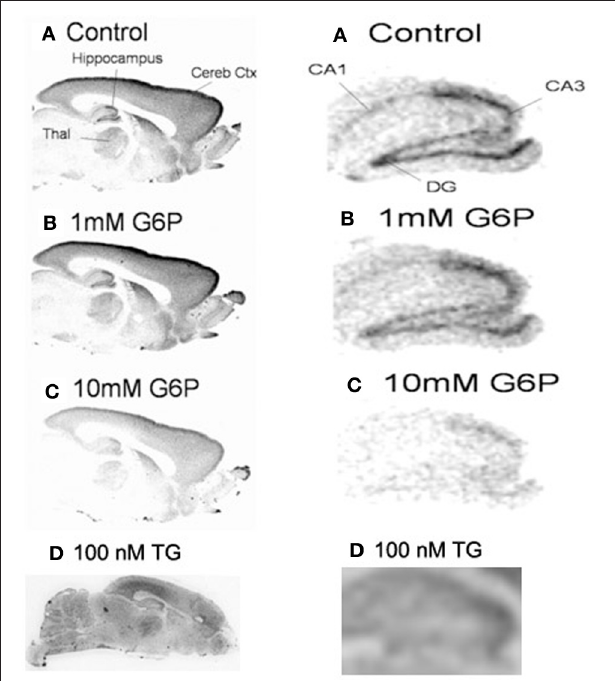
FIGURE 2 | In fresh frozen rat brain sections, glucose-6-phosphate caused a generalized reduction in the accumulation of 45 Ca 2 + . Treatment of fresh frozen brain sections with glucose-6-phosphate (10mM) or thapsigargin (1 µ M), revealed very similar pattern of generalized reduction in 45 Ca 2 + accumulation in gray and white matter. No regional specificity was observed, as the effect of both treatments appeared to be a diffuse response. Images are representative of n =